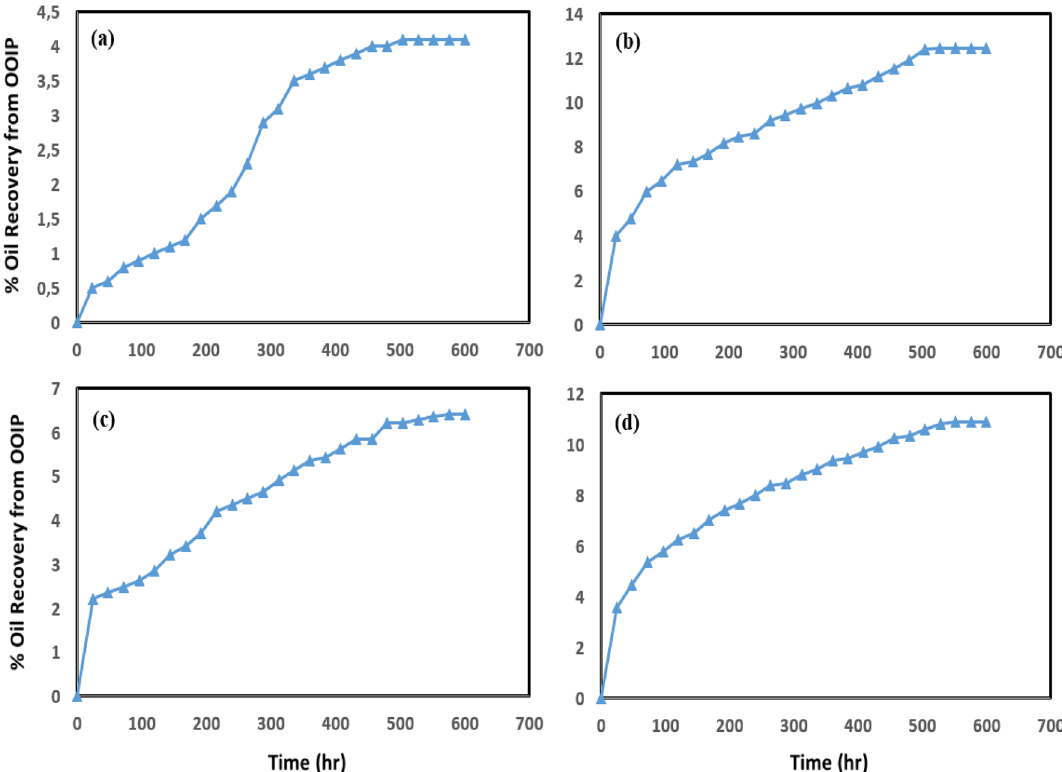
Figure 3. Spontaneous oil production from carbonate saturated-oil plugs in Amott cell at 90 °C ( a ) core II; treated with SWP ( b ) core A; treated with 500-PE-cit-ANPs nanofluid ( c ) core B; treated with 500-PE-cit-AQDs nanofluid ( d ) core C; treated with 1000-PE-cit-AQDs